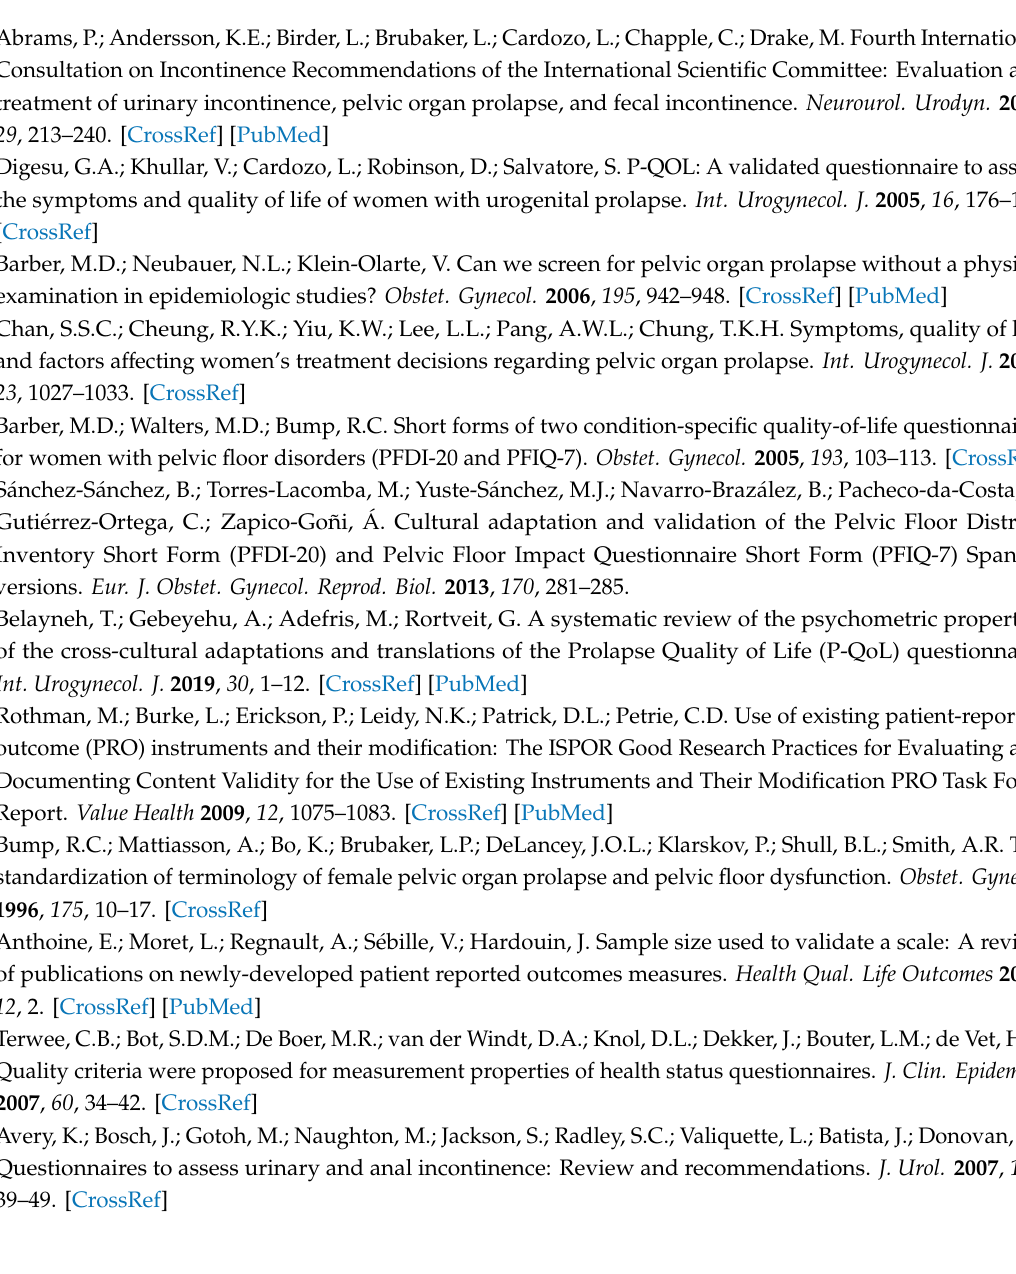
Table S1: Spanish P-QoL; Table S2: Spanish P-QoL